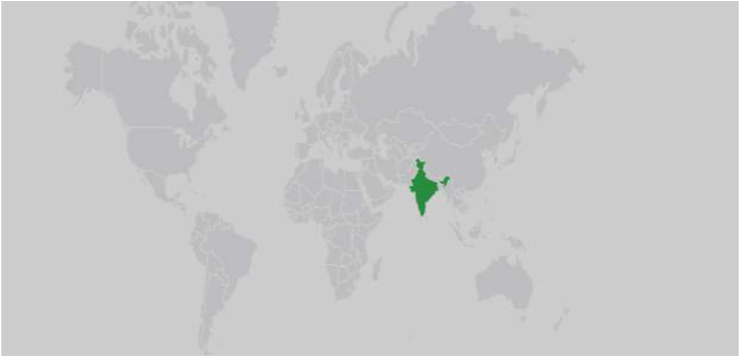
This depicts an Indian endocrine website which is only browsed only by Indians (shaded green). (For interpretation of the references to colour in this figure legend, the reader is referred to the Web version of this article.)